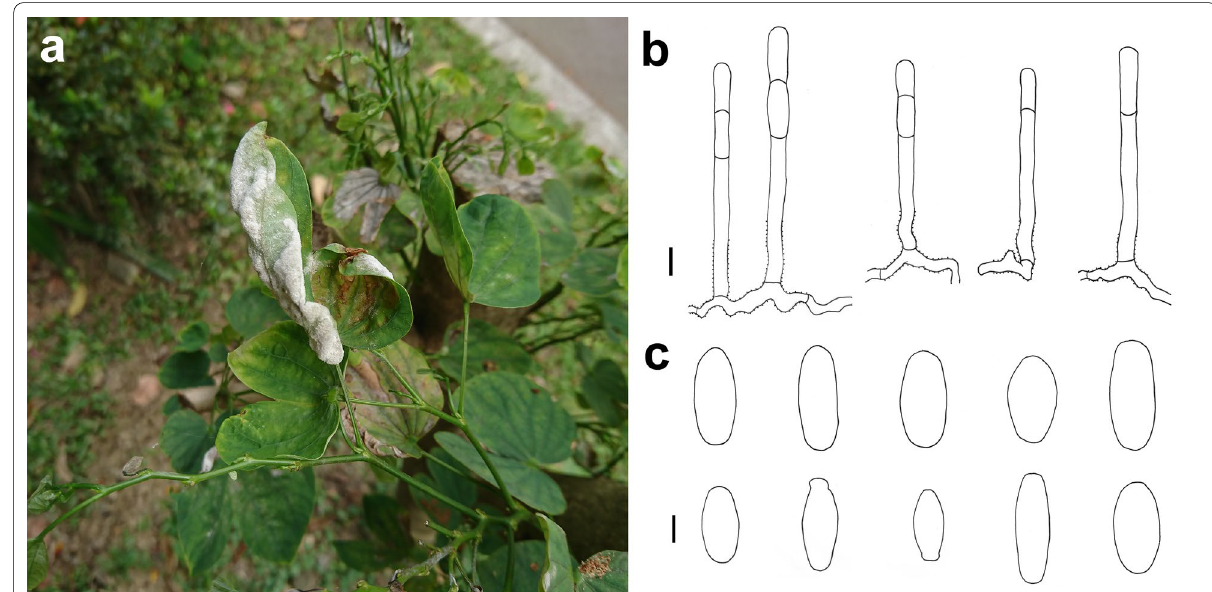
Fig. 5 Erysiphe lespedezae on Bauhinia sp. (AKII 0055) a Powdery mildew symptoms on leaves. b Hyphae with nipple‑shaped appressoria and conidiophores with curved foot cell. c Conidia. Scale bars